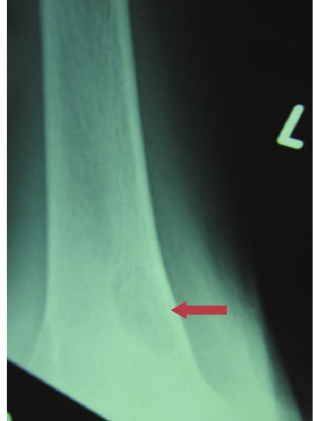
Figure 11: Sign of calcification in the left femur.